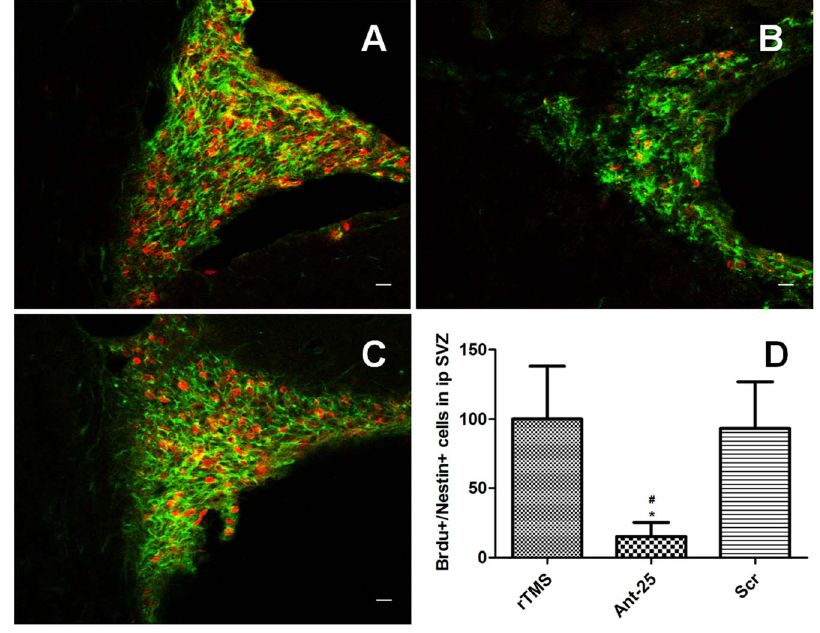
Figure 9. Antagomir-25 injection resulted in decreased proliferation of NSCs 7days after tMCAO. Panels A–C show staining of Brdu + (red)/Nestin + (green) positive cells in the ipsilateral SVZ from rTMS (A), antagomir-25/rTMS (B), and control antagomir/rTMS (C) groups(Bar=20 m m). (D) Quantification analysis of the number of Brdu + /Nestin + positive cells in the ipsilateral SVZ at 7 days after tMCAO. # P =0.006 versus rTMS group; * P =0.013 versus Scr group. SVZ, subventricular